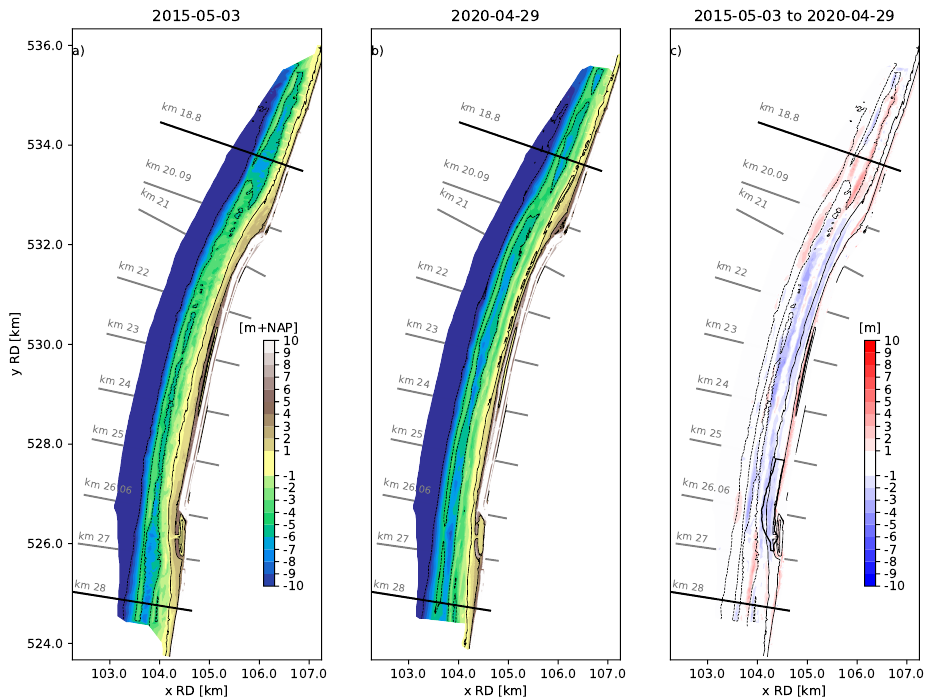
Figure 5. Bed elevation data shortly after construction in May 2015 (panel ( a )) and after five years in April 2020 (panel ( b )). Colors show the bed elevation in meters with respect to the NAP datum (approximately MSL). Panel ( c )) represents the erosion (blue colors) and sedimentation (red colors) between the two surveys five years apart. The black dotted contour lines are based on the bed elevation of May 2015 (in panel ( a )/( c )) or 2020 (in panel ( b )) and indicate the − 10, − 4.8, 0, and 3 m + NAP isobaths. The black solid lines delineate the nourishment boundaries (km 18.8–28). The location of the additional 2018 beach nourishment is indicated with the black